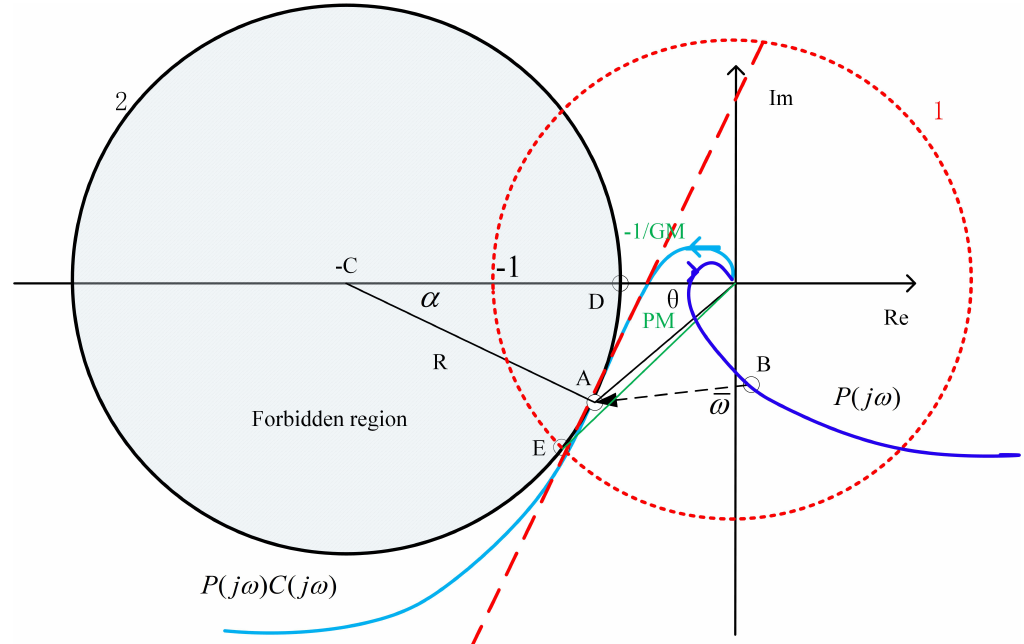
Figure 2. Graphic illustration of the KC autotuning principle [43] (reproduced with permission from Zhao, S.; Ionescu, C.M.; De Keyser, R.; and Liu, S. In 3rd IFAC Conference in Advances in Proportional-Integral-Derivative Control; published by Elsevier,